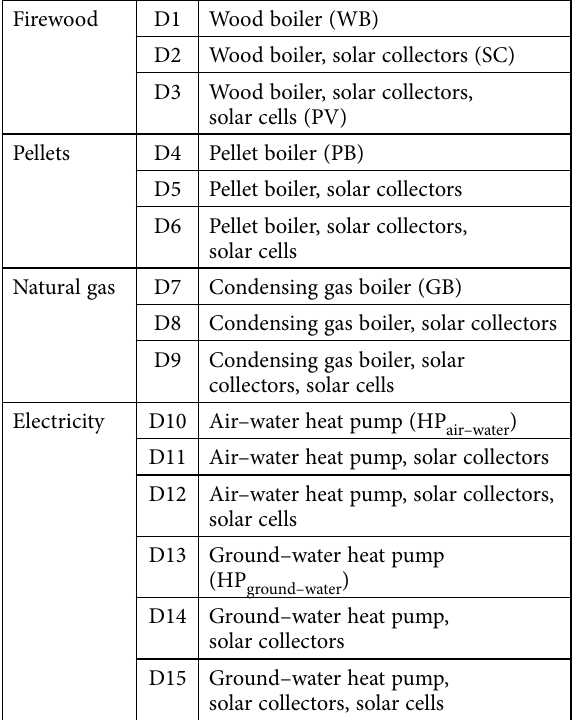
Table 1. Selected combinations of technologies for the